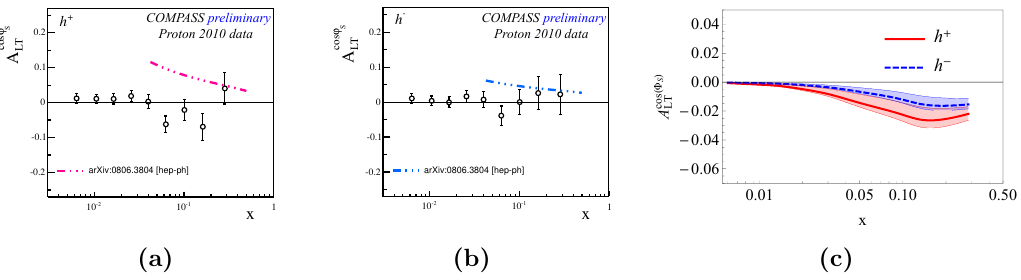
Figure 14. Subleading-twist asymmetry A cos (cid:30) S